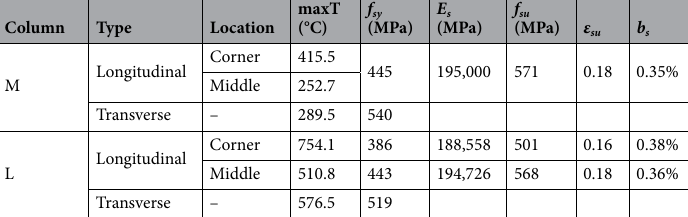
Table 3. Key properties of reinforcing steel for the two post-fire scenarios.